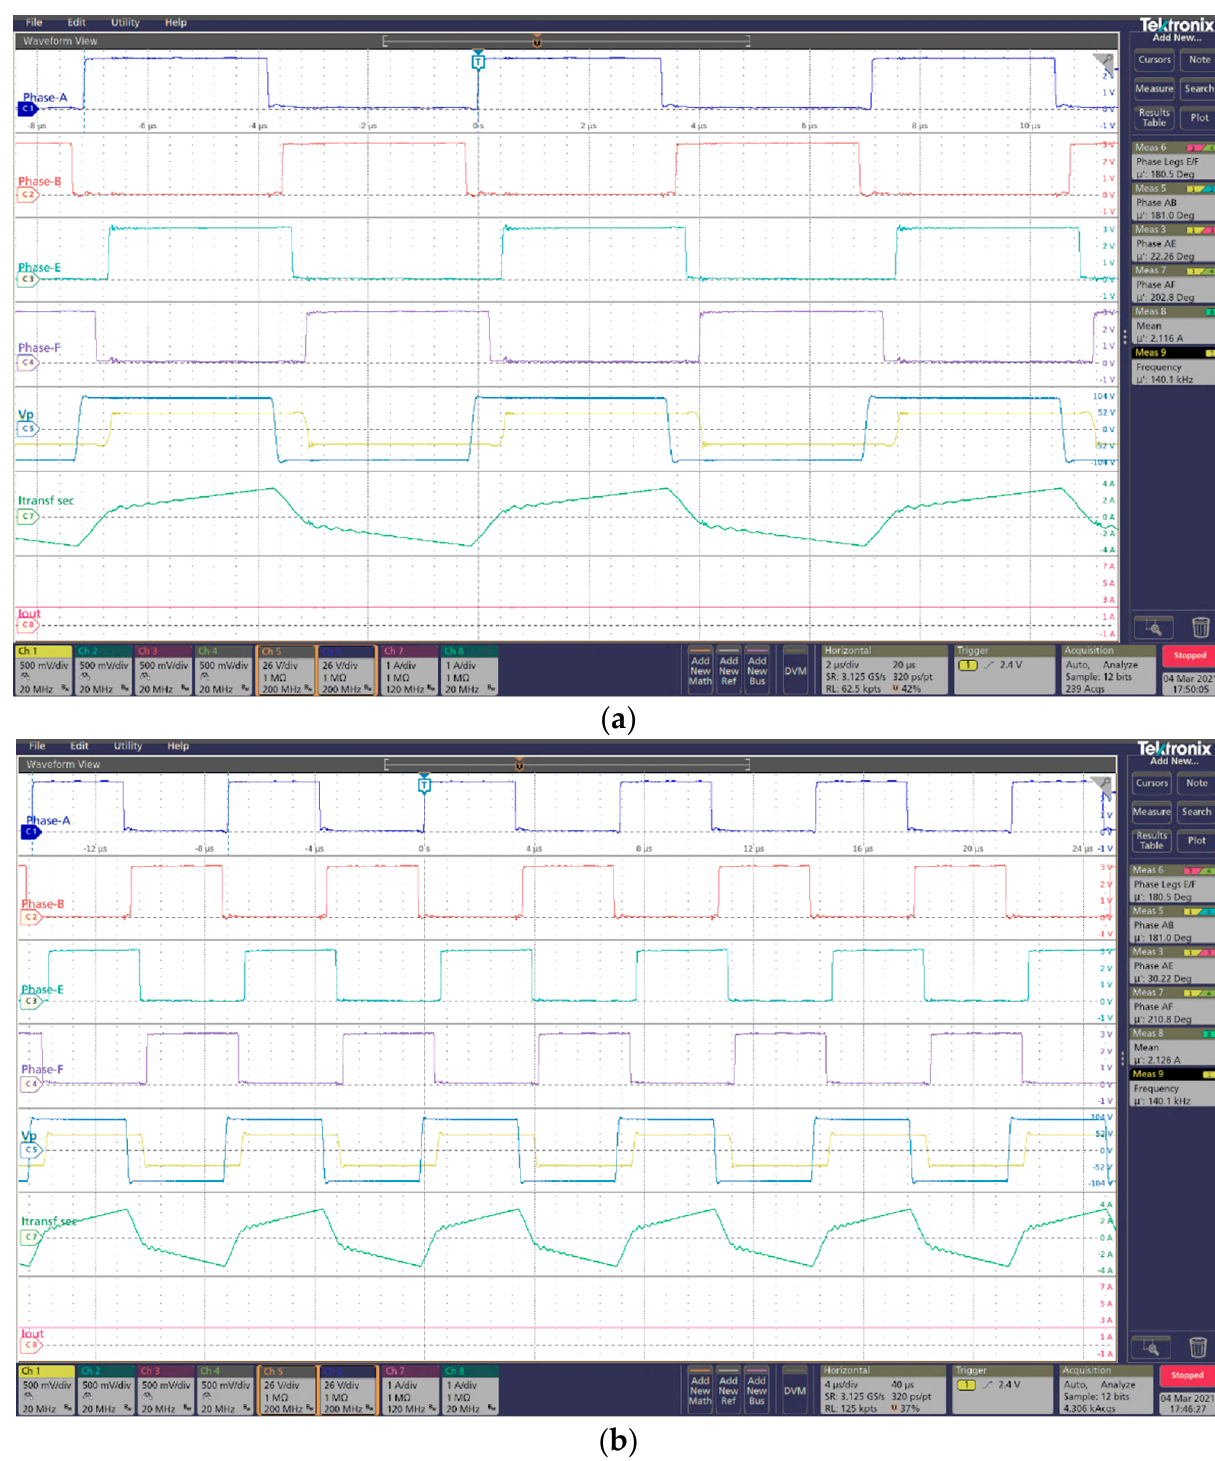
Figure 17. Gate control signals, transformer’s primary and secondary voltage, inductor current and output current average of the experimental model at 140 kHz: ( a ) Case 2; ( b ) Case 3.